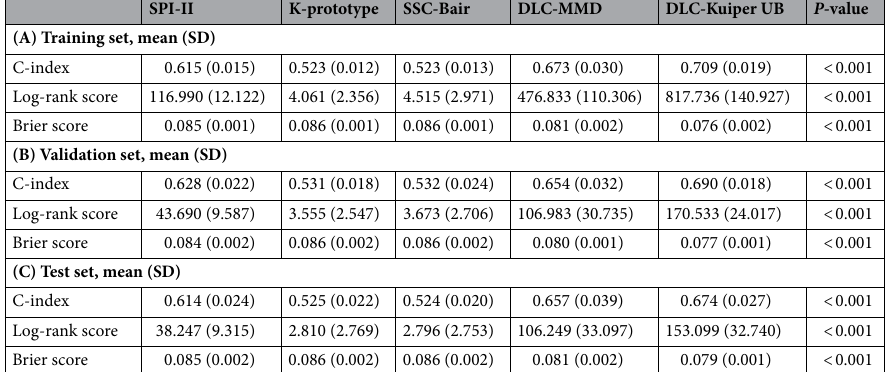
Table 2. C-index, Log-rank score, and Brier score for different clustering methods in datasets. P -value; One- Way ANOVA.